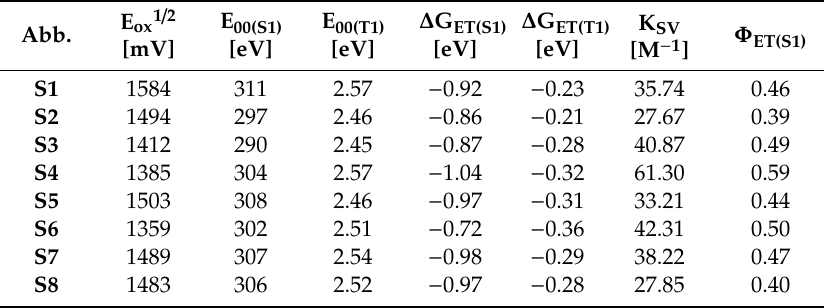
Table 2. Parameters characterising the photochemical reactivity of the 2-amino-4,6-diphenyl-pyridine- 3-carbonitrile derivatives with diphenyliodonium